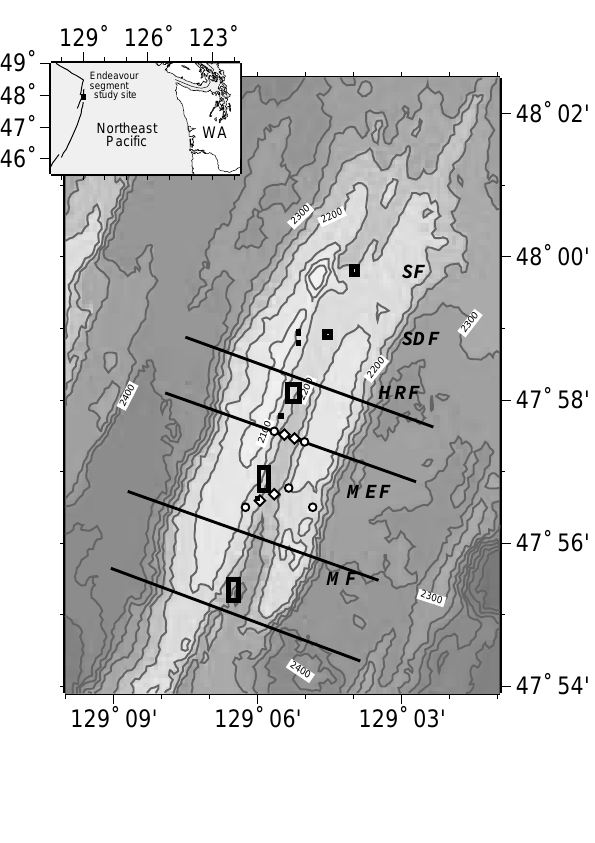
Figure 3. Topography of the Endeavour Segment showing major vent fields (the open boxes; from south to north Mothra, Main Endeavour, High Rise, Salty Dawg and Sasquatch) and areas of diffuse venting (small closed boxes). Topographic data as in Figure 1. The open symbols on the sections north of MEF, obliquely across the valley south of MEF and in the saddle on the east ridge wall show locations for the first year deployment of instrumentation; diamonds are upward-looking ADCPs, circles conventional moorings. Depending on analysis of these data the instrument may remain in these locations for a second year or be redeployed along the four sections which bound the three southern vent fields (see